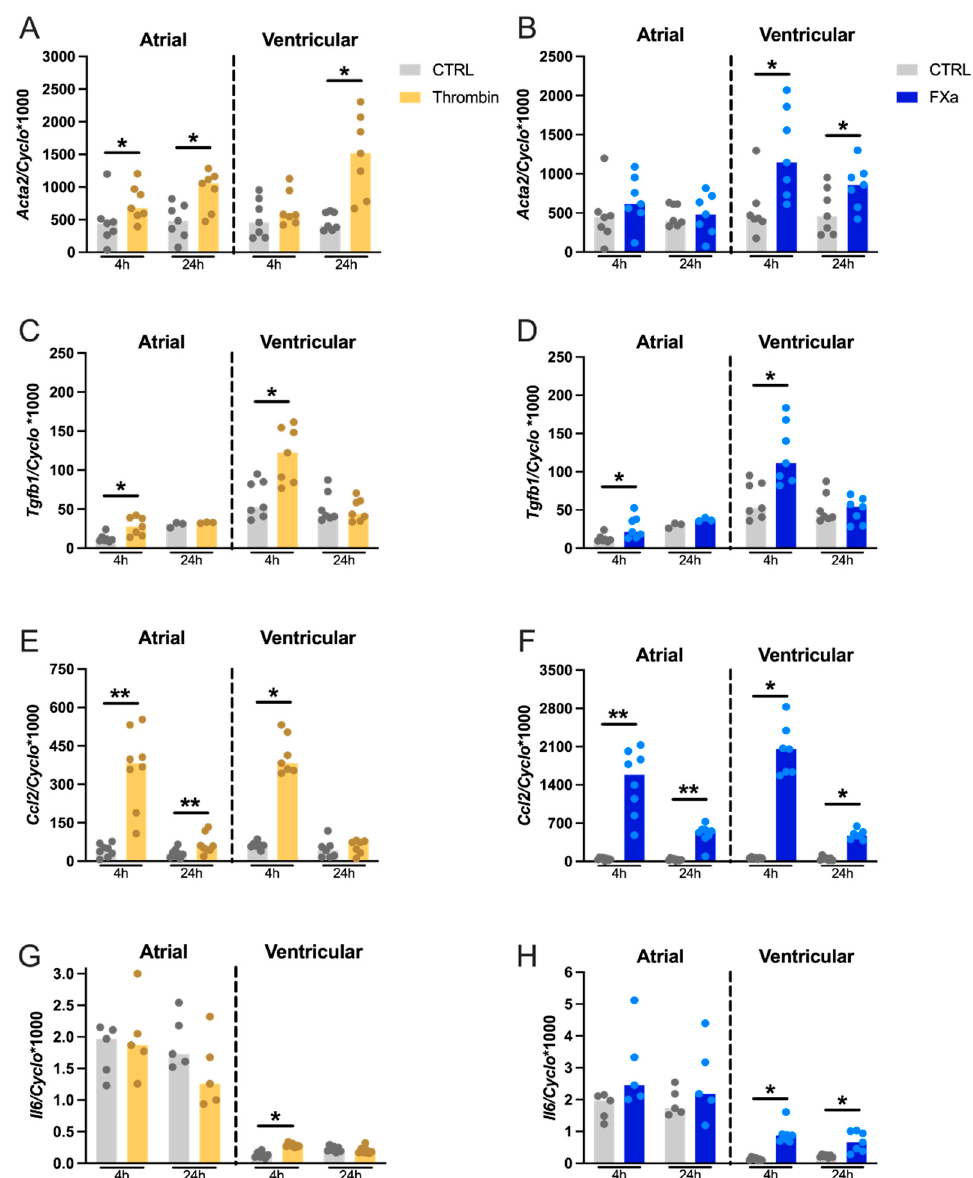
Figure 1. Effect of thrombin ( A , C , E , G ) and FXa ( B , D , F , H ) on mRNA expression of pro-fibrotic and proinflammatory genes. Rat atrial ( n = 3–8) and ventricular ( n = 7) CF were stimulated with 8 pM of thrombin or 100 nM of FXa for 4 and 24 h. Gene expression of Acta2 ( A , B ), Tgfb1 ( C , D ), Ccl2 ( E , F ), and Il6 ( G , H ) was measured by RT-qPCR. Data were normalized to the housekeeping gene Cyclophilin-A. Results are expressed as median bars, with dots indicating separate CF isolations. Statistical analysis was performed using the non-parametric Wilcoxon test for paired samples ( *p < 0.05, **p < 0.01, ***p < 0.001, ****p < 0.0001 ) .